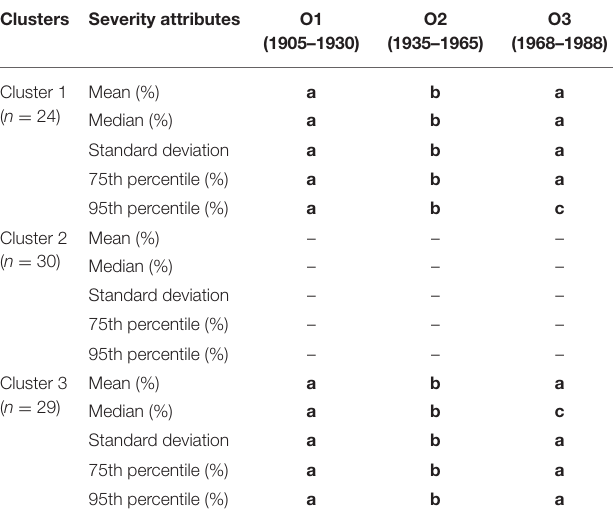
TABLE 3 | Results of the pairwise comparisons of severity attributes (mean, median, 75 th and 95 th percentile of the percentage of trees affected by SBW for each of study sites and outbreak period) between the different SBW outbreaks per cluster, where a > b > c. Clusters Severity